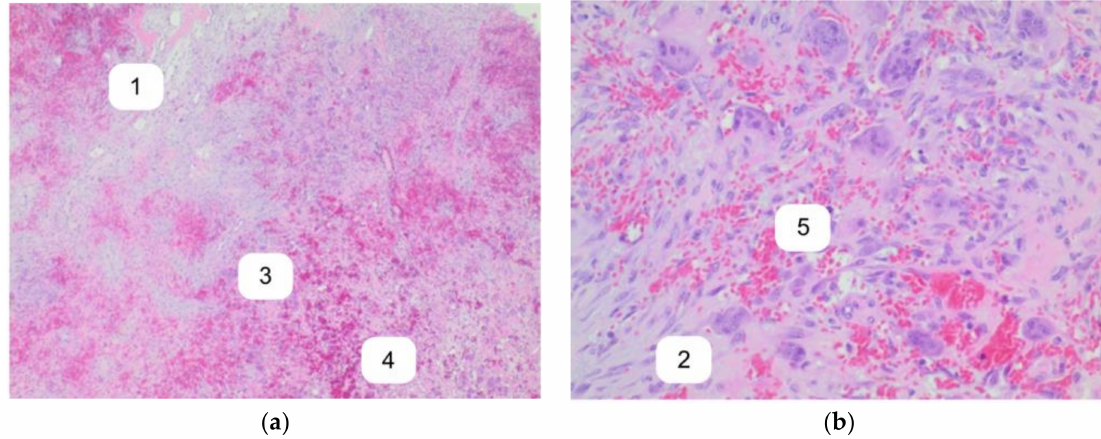
Figure 4. H&E stains show a giant cell lesion consisting of plump fibroblasts (1) and numerous osteoclast-like giant cells (2) surrounded by reactive bone formation (3). Extensive hemorrhage, focal deposits of hemosiderin (4), and small blood vessels (5) are present. Atypical cells are not found. Original magnification: ( a ) 12.5 × and ( b ) 200 ×